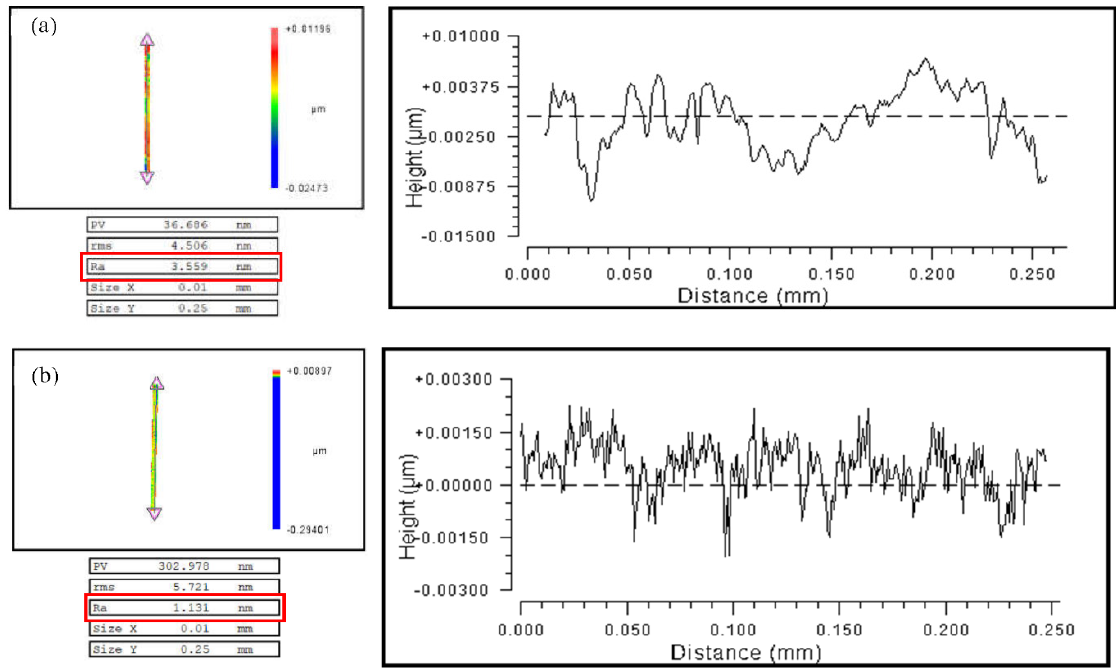
Figure 14. Roughness test of convex grating blaze surface of different workpiece materials along the equal-along-projection layout ( a ) RSA6061 ( b ) RSA6061+ chemically plated NiP.